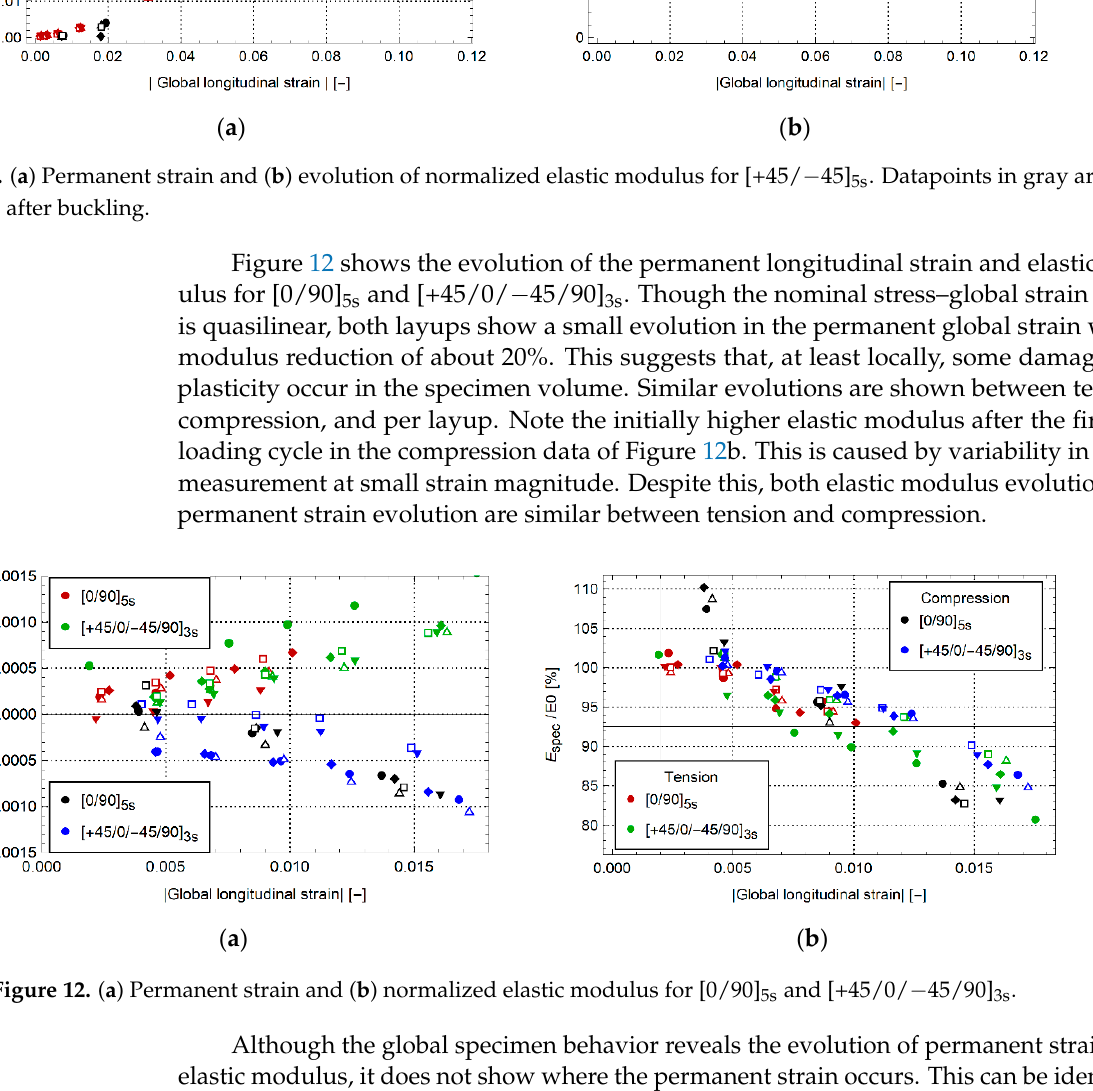
− 45/90] 5s and [+45/0/ 3s